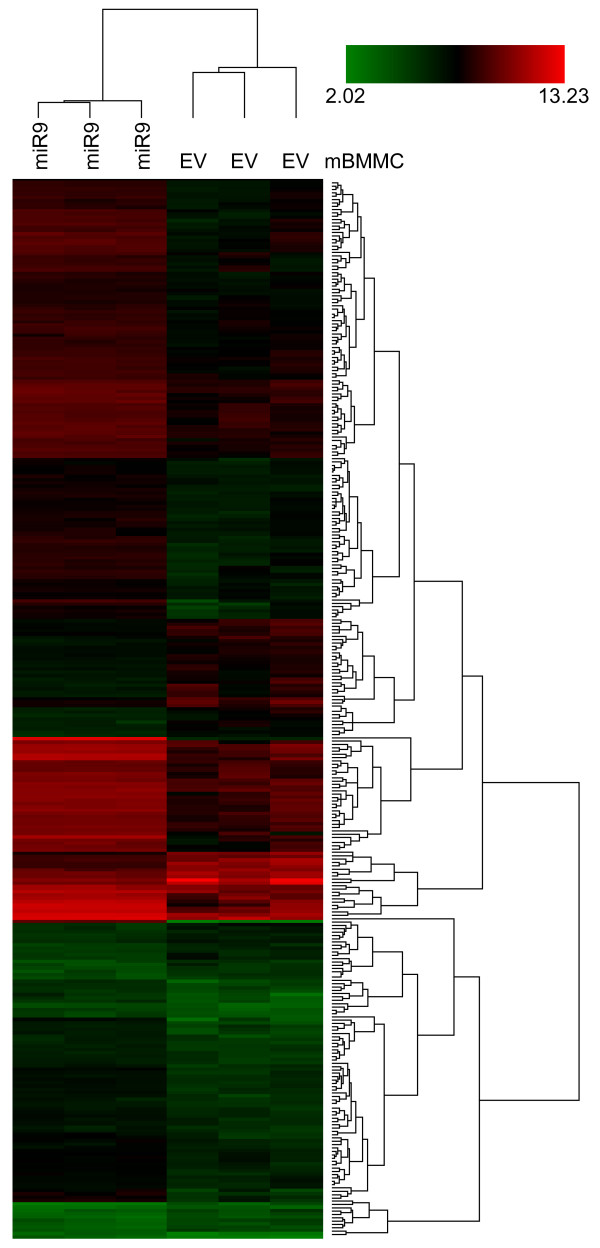
Overexpression of miR-9 in normal mouse bone marrow-derived mast cells significantly alters gene expression. Normal mBMMCs transduced with pre-miR-9-3 lentivirus or empty vector control were sorted based on GFP expression. RNA was harvested from mouse BMMCs transduced with empty vector or pre-miR-9-3 lentivirus from three separate transduction experiments. Transcriptional profiling was performed using Affymetrix GeneChip® Mouse Gene 2.0 ST Arrays. Hierarchical clustering was performed for 450 genes differentially expressed (p < 0.05) in mBMMCs expressing either empty vector (EV) or miR-9 (miR9) as determined by one-way ANOVA comparison test (p < 0.05). Mean centered signal intensities of gene-expression are depicted by the log2 of the ratio of the signals against the average signal for each comparison. Color areas indicate relative expression of each gene after log2 transformation with respect to the gene median expression (red above, green below, and black equal to the mean).